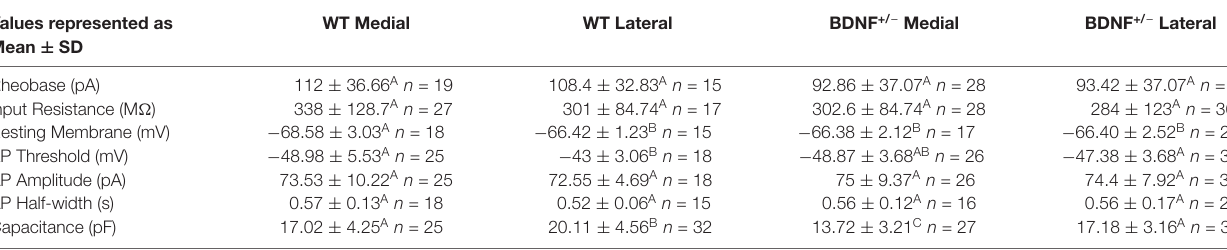
TABLE 1 | Summary of intrinsic properties of MNTB neurons. Values represented as Mean ±